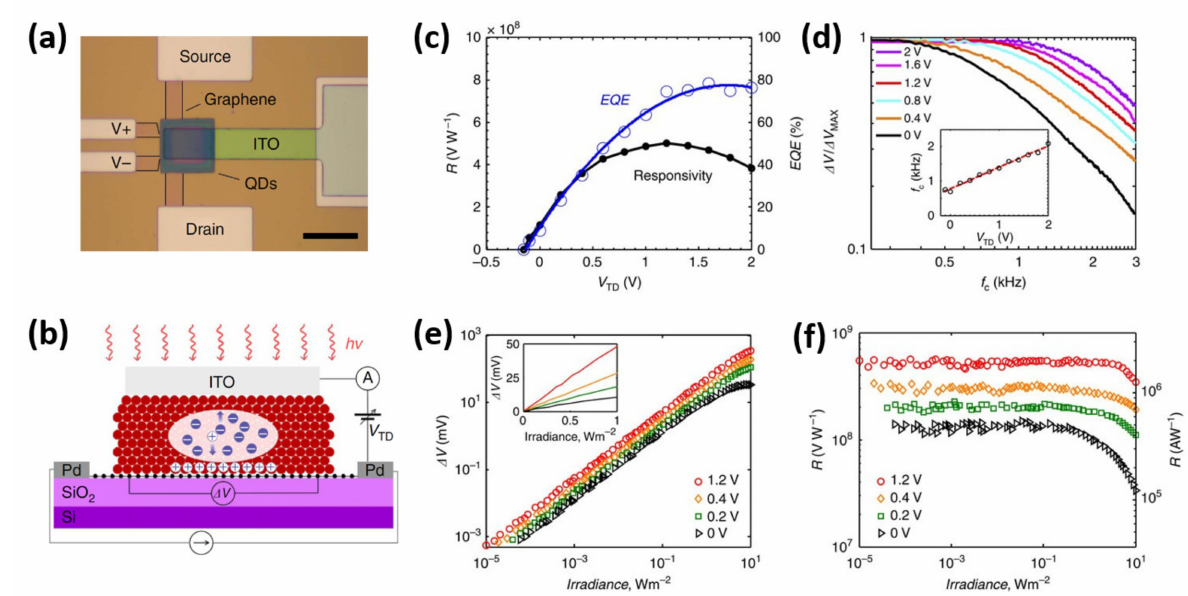
Figure 13. ( a ) Optical image of the hybrid graphene transistor-CQD photodiode detector. ( b ) Schematic of phototransistor operation. ( c ) Responsivity and EQE of the visible/near-infrared phototransistor. ( d ) Normalized photoresponse as a function of light modulation frequency. Inset: extracted 3 dB bandwidth values. ( e ) Photo-induced signal as a function of incident irradiance, inset demonstrates the linearity of photoresponse for high irradiance values. ( f ) Measured responsivity of the detector in VW − 1 (left axis) and responsivity converted in AW − 1 (right axis). [145] Figure reproduced with permission from Springer Nature.